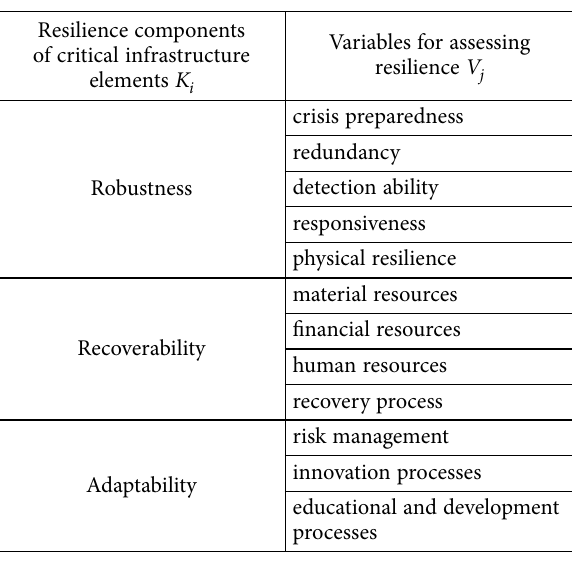
Table 4. Variables determining the resilience of critical infrastructure elements (Rehak et al. 2019a)